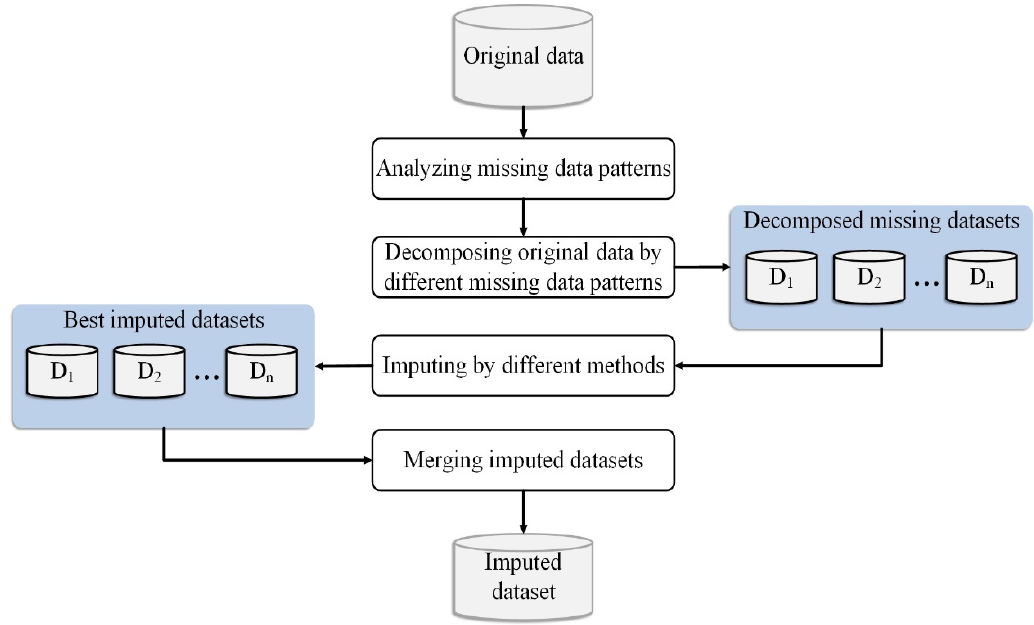
Figure 1. The introduced model for imputing multi-pattern missing data.